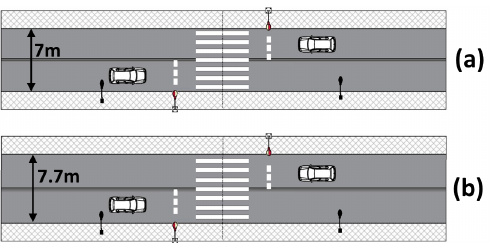
Figure 5. Scenario 2: ( a ) The reference pedestrian crossing. ( b ) Road width increased by 10% relative to ( a